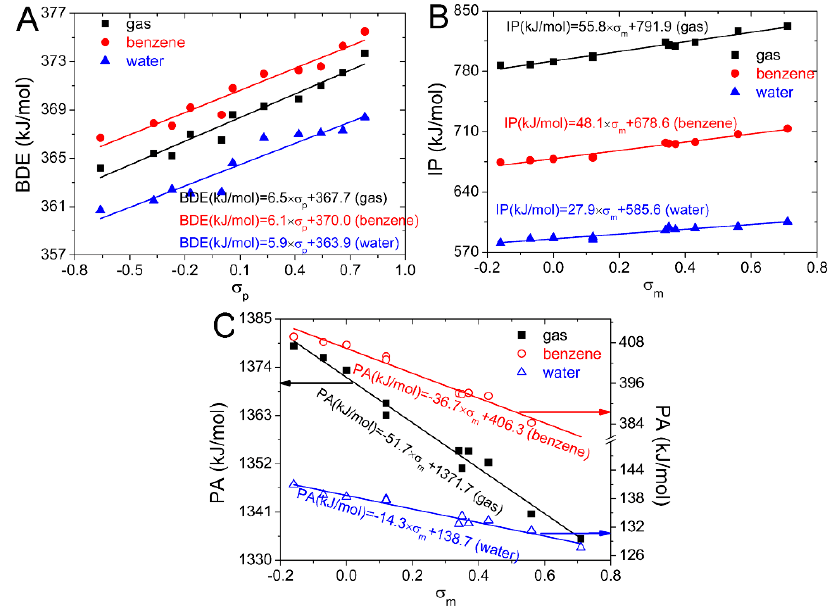
Figure 3. Dependence of BDE ( A ), IP ( B ) and PA ( C) on Hammett sigma constants for naringenin in gas, benzene and water phases.